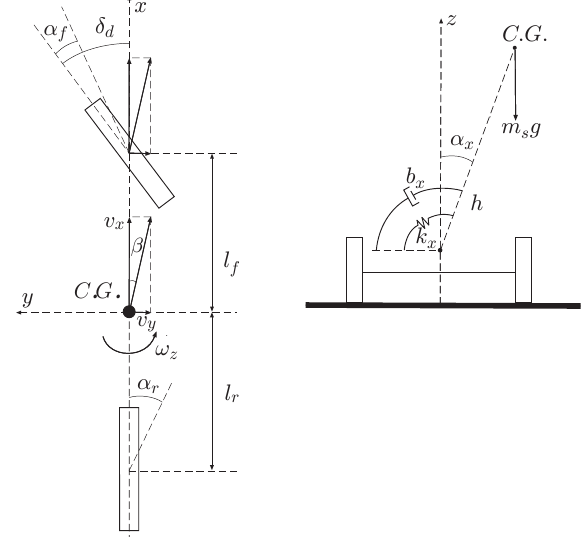
Figure 2. Bicycle model with roll